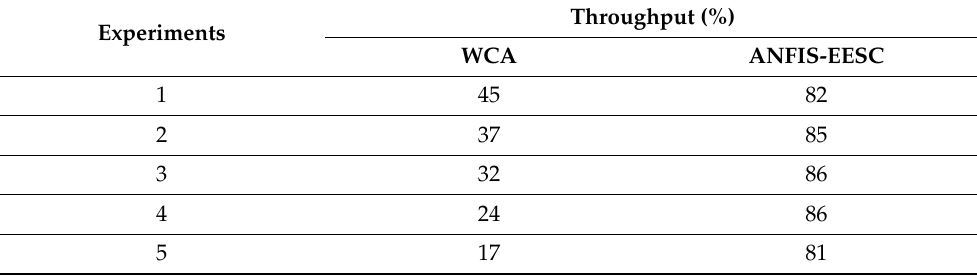
Table 5. Performance comparison based on throughput.